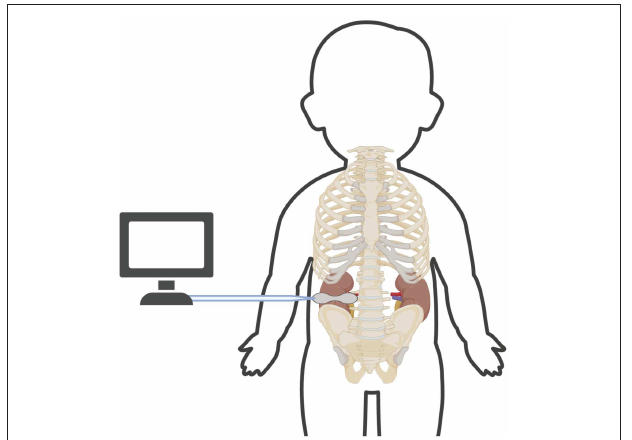
FIGURE 1 | Proper location of neonatal renal NIRS sensor. This image shows the proper placement of neonatal renal NIRS sensor below the costal margin and above the iliac crest with the tip of the sensor lateral to the spine and reading end of the sensor wrapping around the side.